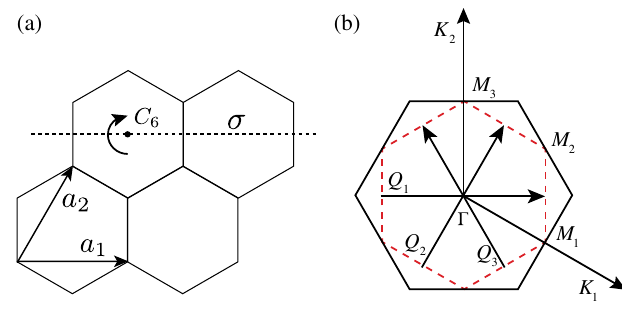
FIG. 1. (a) Symmetries of the honeycomb lattice. (b) Nested Fermi surface at 1 = 4 doping.